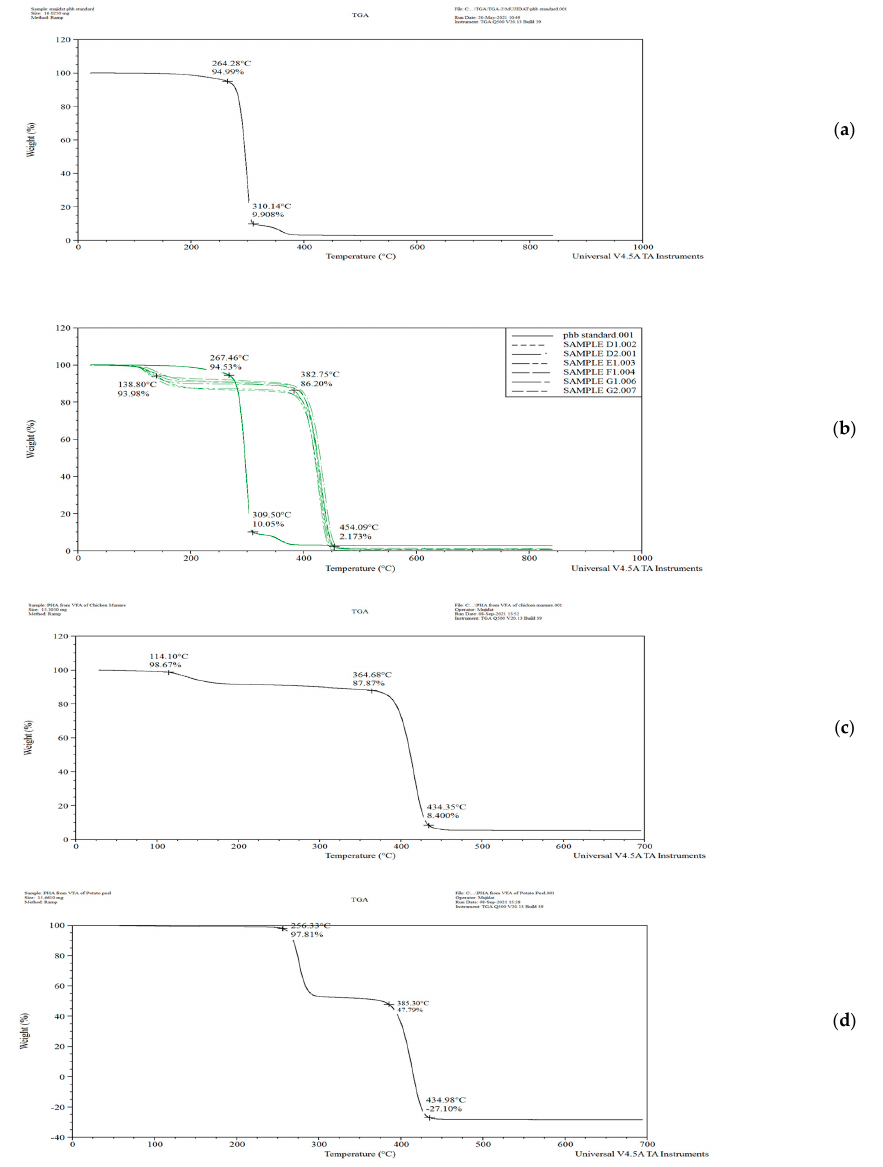
Figure 6. TGA thermograms of ( a ) commercial PHB, ( b ) PHAs from synthetic VFAs, ( c ) PHAs from volatile fatty acids from chicken manure, and ( d ) PHAs from volatile fatty acids from potato peels.